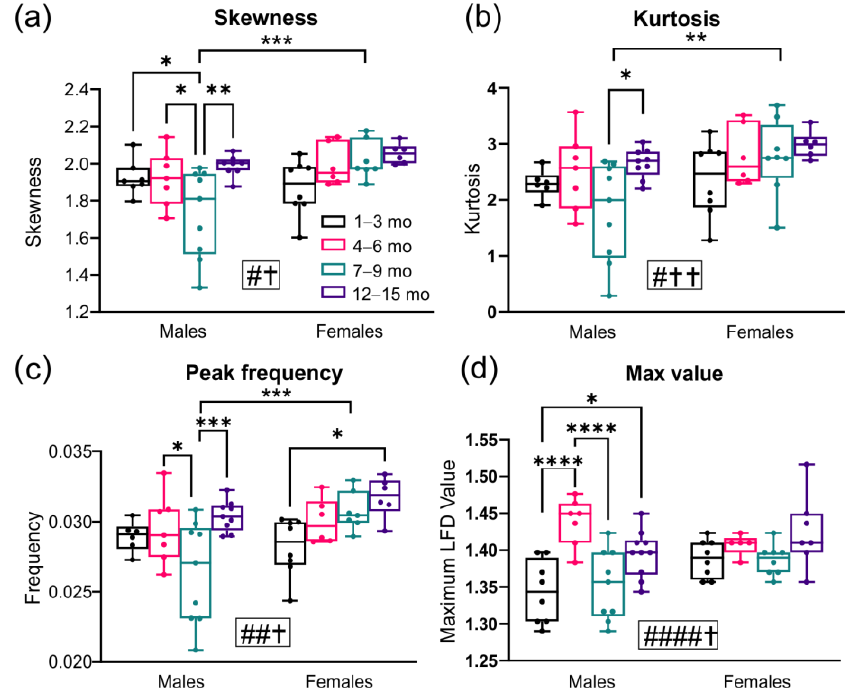
Figure 5. Local fractal dimension (LFD) histogram analyses. Analysis of LFD histograms for skewness ( a ), kurtosis ( b ), peak frequency value ( c ), and maximum LFD values ( d ) in aging male and female 3xTg-AD mice. Males consistently exhibited significant temporal changes in skewness, peak frequency, and maximum LFD value compared to females. The 7 – 9 month timepoint showed significant differences between males and females, but these differences were not observed at other timepoints. * p < 0.05, ** p < 0.01, *** p < 0.001, **** p < 0.0001. # shows a significant effect of age with # p < 0.05, ## p < 0.01, #### p < 0.0001; † shows a significant effect of sex with † p < 0 .05, †† p < 0.01.